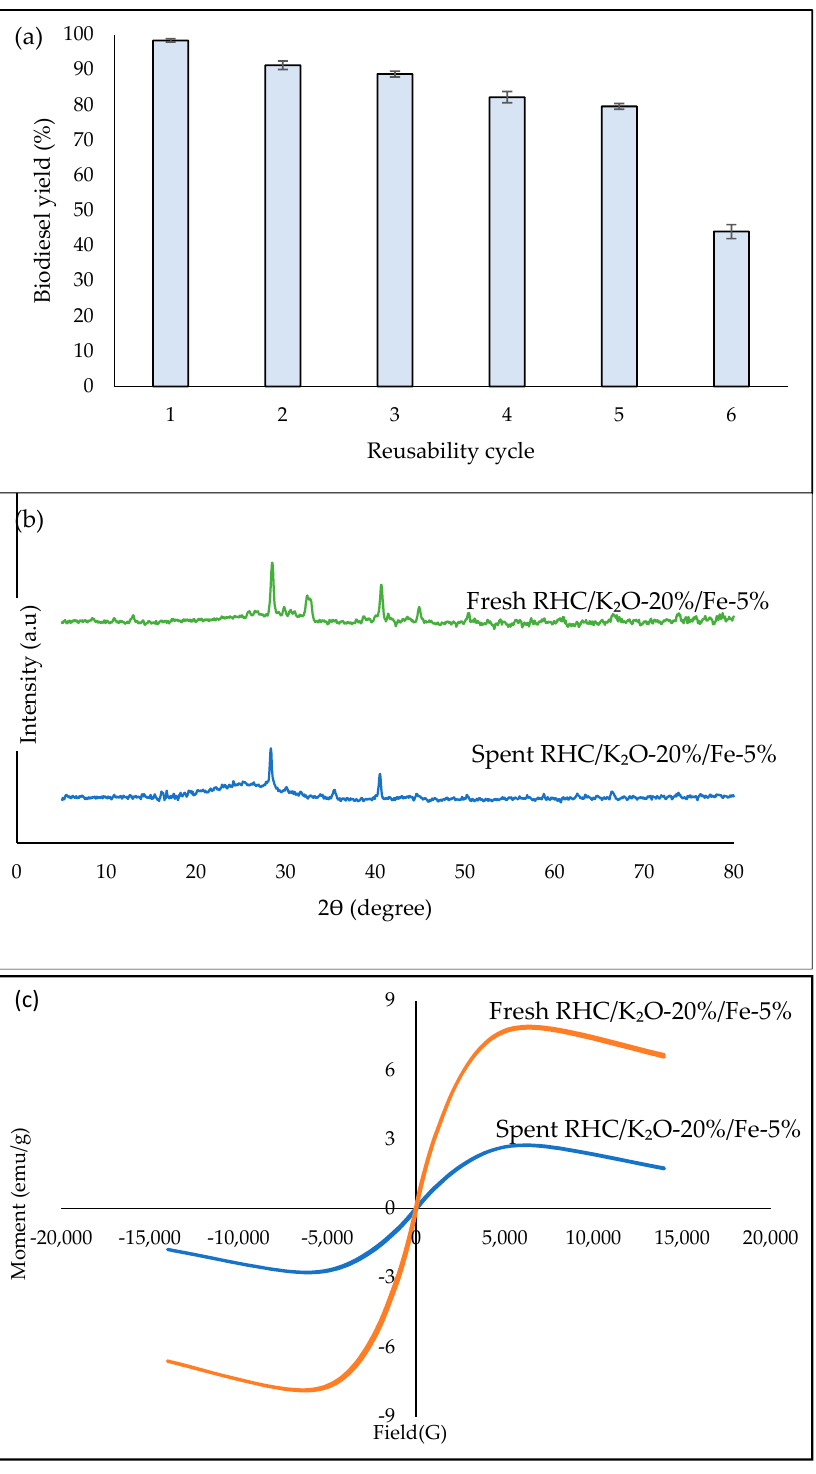
Figure 8. ( a ) Reusability of the RHC / K 2 O-20% / Fe-5% catalyst in biodiesel production ( b ) XRD pattern of fresh RHC / K 2 O-20% / Fe-5% and spent RHC / K 2 O-20% / Fe-5%, ( c ) Magnetic strength (VSM).